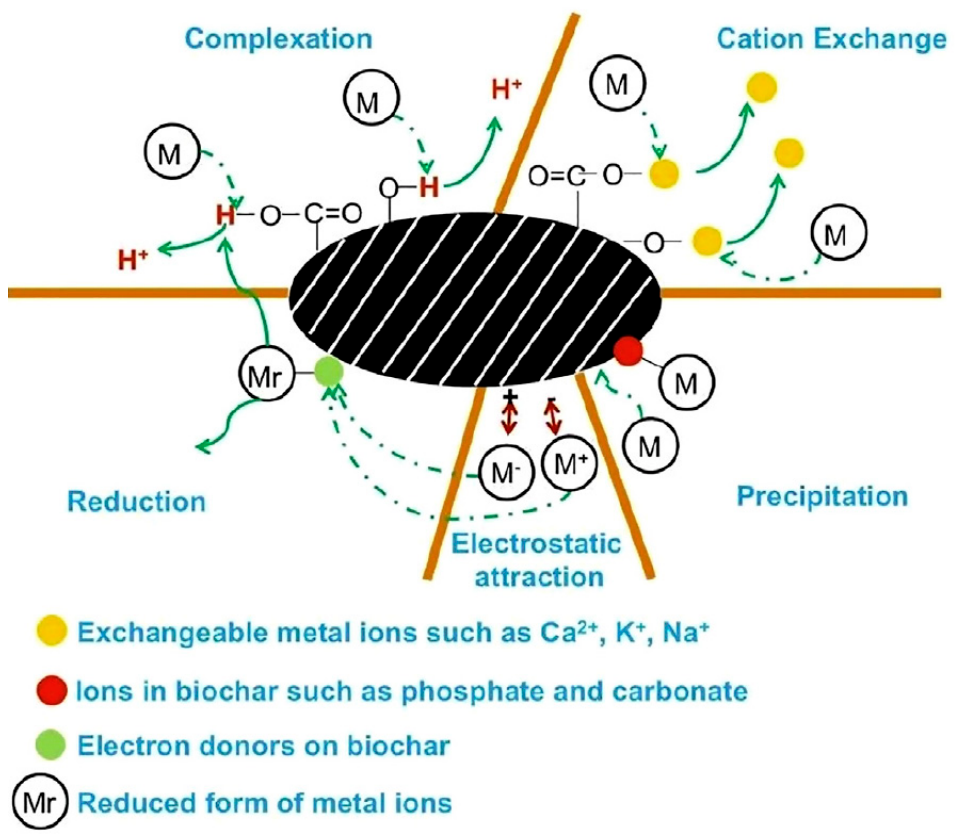
Figure 2. Mechanism of heavy metal adsorption onto neat biochar surface, as illustrated by Li et al. [ 82].